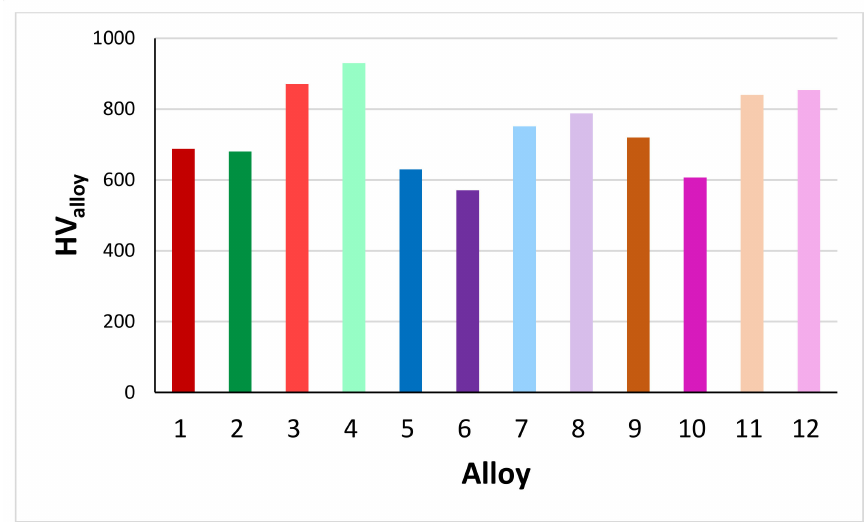
Figure 11. Room temperature Vickers hardness of AC and HT alloys. Odd numbers AC alloys, even numbers HT alloys. TT2 (1, 2), ZF4 (3, 4), TT3 (5, 6), ZF5 (7, 8), TT4 (9, 10), ZF6 (11, 12). See Appendix A for nominal compositions of